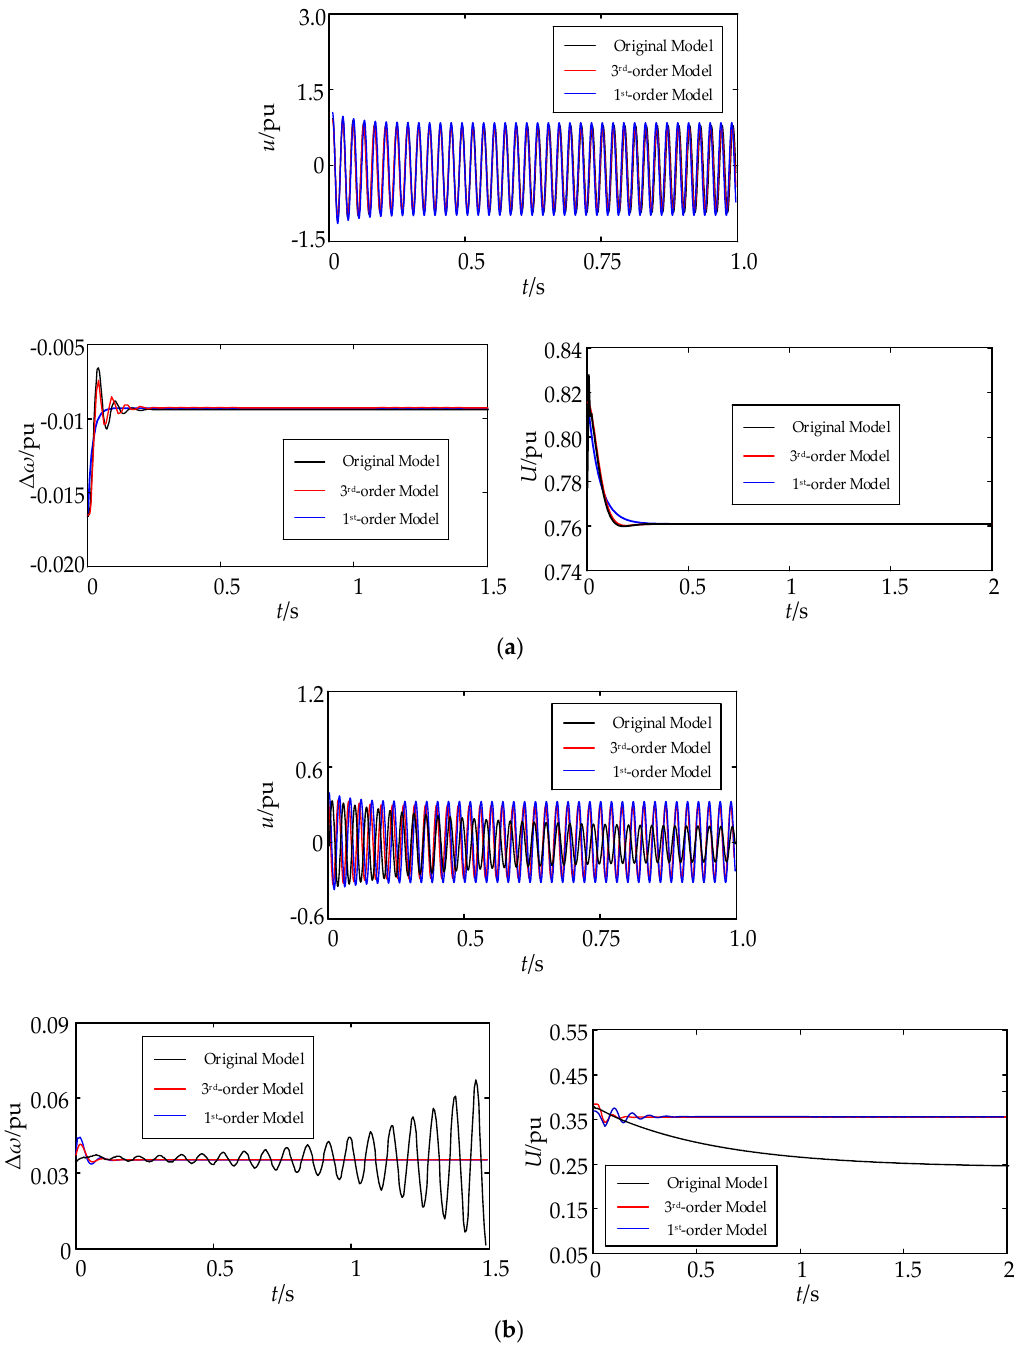
Figure 8. Simulation results of test system 2: ( a ) at the stable point; ( b ) at the unstable point. Table 10. Consistency indexes of dynamic response for reduction models in microgrid system.